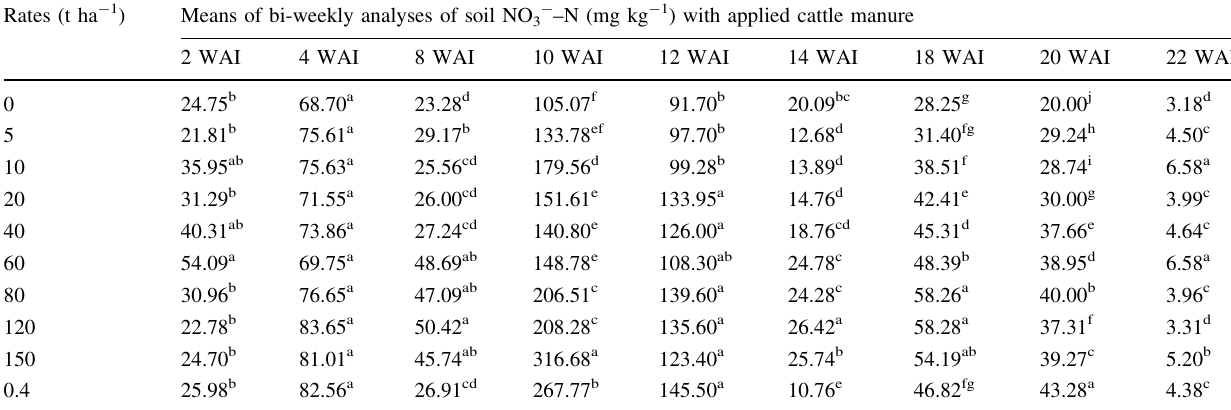
Table 8 Influence of cattle manure rates and NPK fertilizer (t ha - 1 ) on mean soil NO 3 - –N (mg kg - 1 ) at 2 weeks intervals Rates (t ha - 1